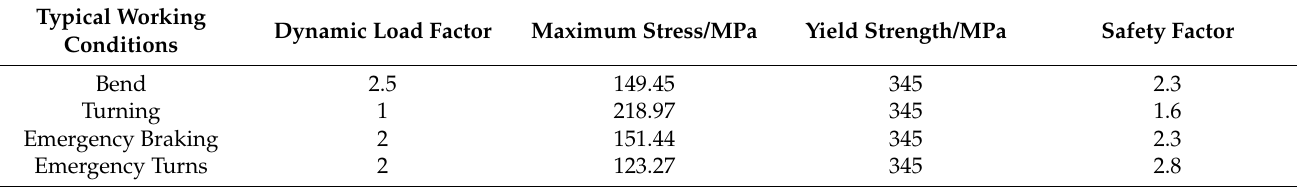
Table 4. Frame static strength evaluation